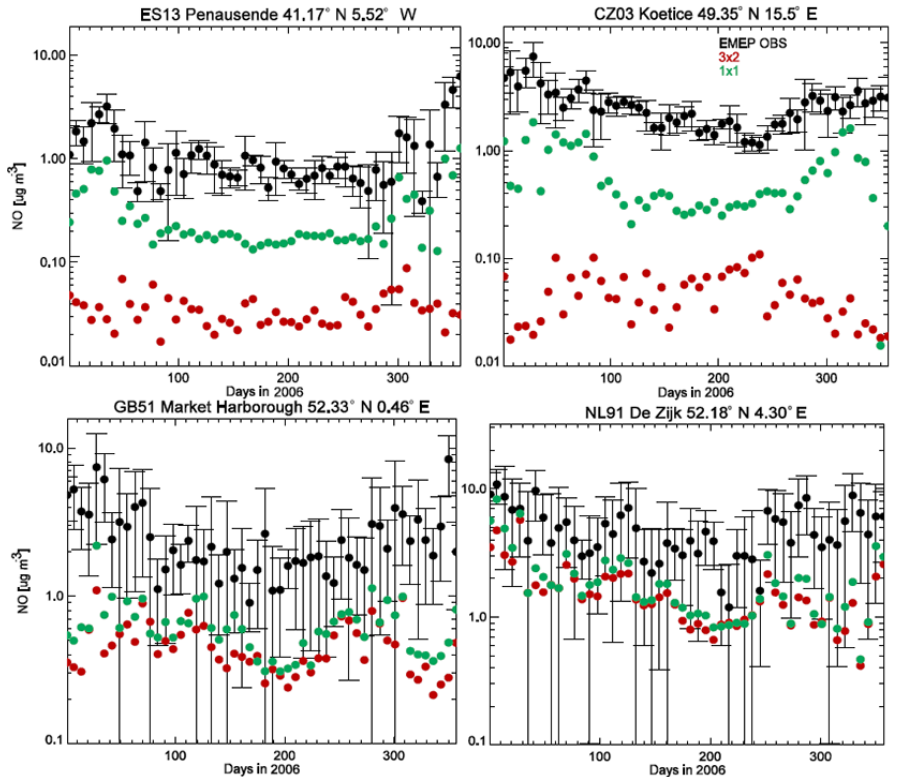
Figure 5. Comparison of TM5-MP weekly [NO] sampled at 13:00UT each day during 2006 with observed [NO] (µgm − 3 ) . The selected sites shown are in the Czech Republic (top left), Spain (top right), Great Britain (bottom left) and the Netherlands (bottom right).